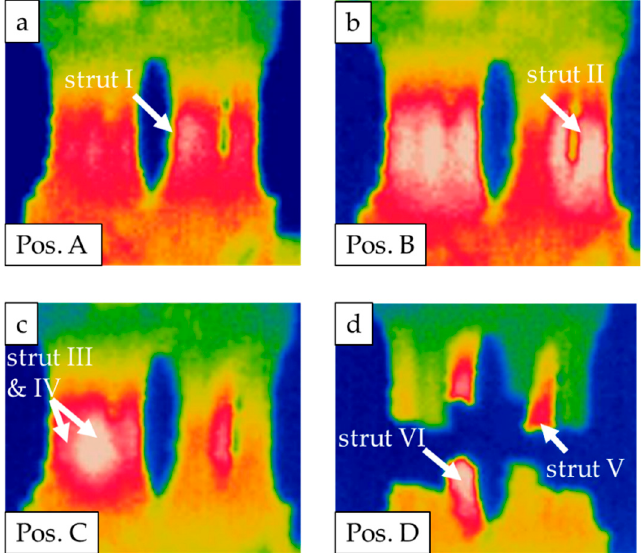
Figure 10. Thermography images of single strut failure: ( a ) strut I, ( b ) strut II, ( c ) struts III and IV and ( d ) struts V and VI.